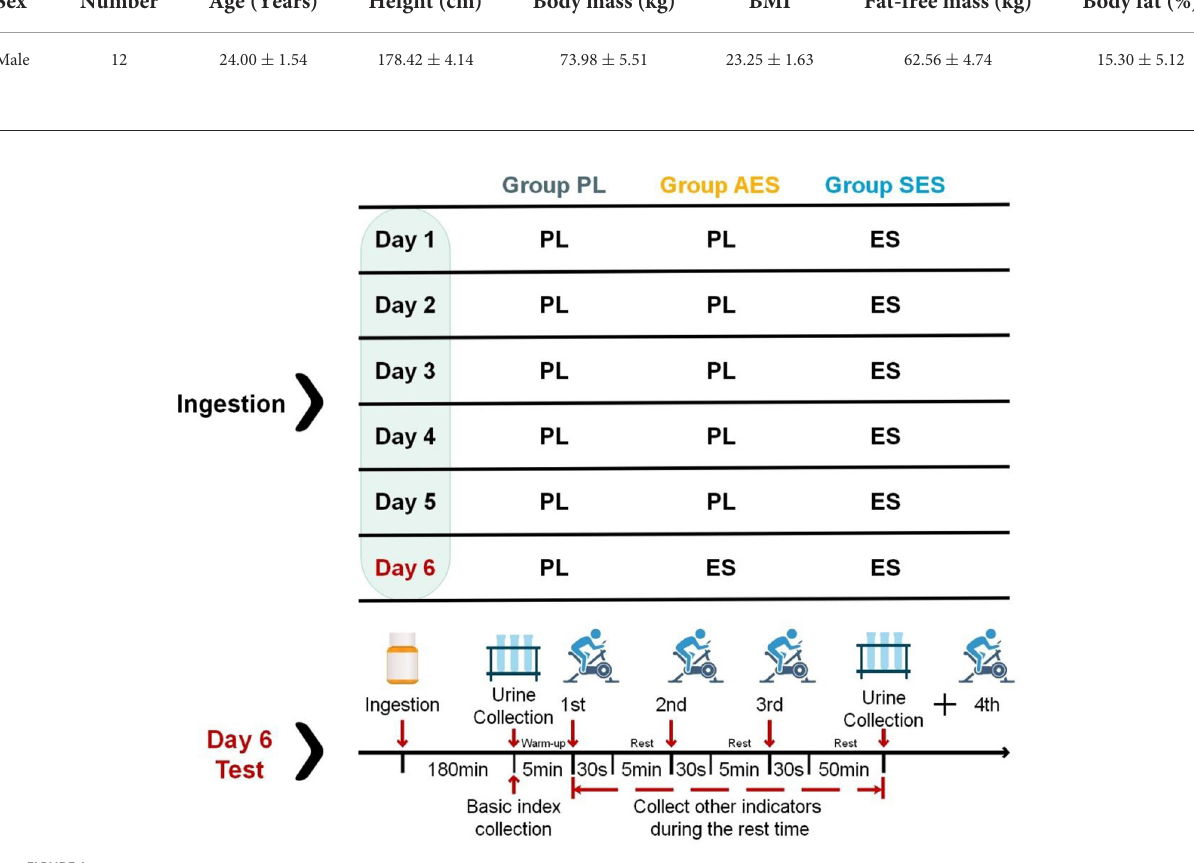
FIGURE1 Experimental design for the three trials: placebo group (PL), acute enteric-coated sodium bicarbonate group (AES), and serial enteric-coated sodium bicarbonate group (SES). The ES doses on days 1–5 were taken in equal amounts at breakfast, lunch, and dinner. All the doses were taken on day 6 (pre-test) commenced 180min before test